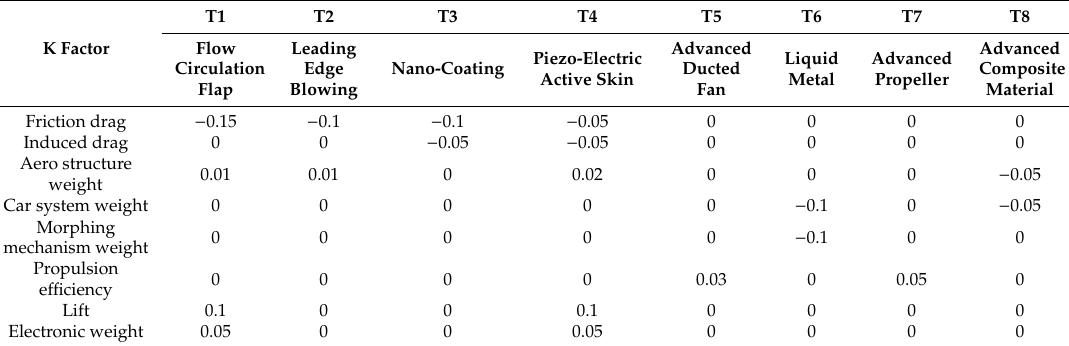
Table 10. Technology impact matrix for identified applicable